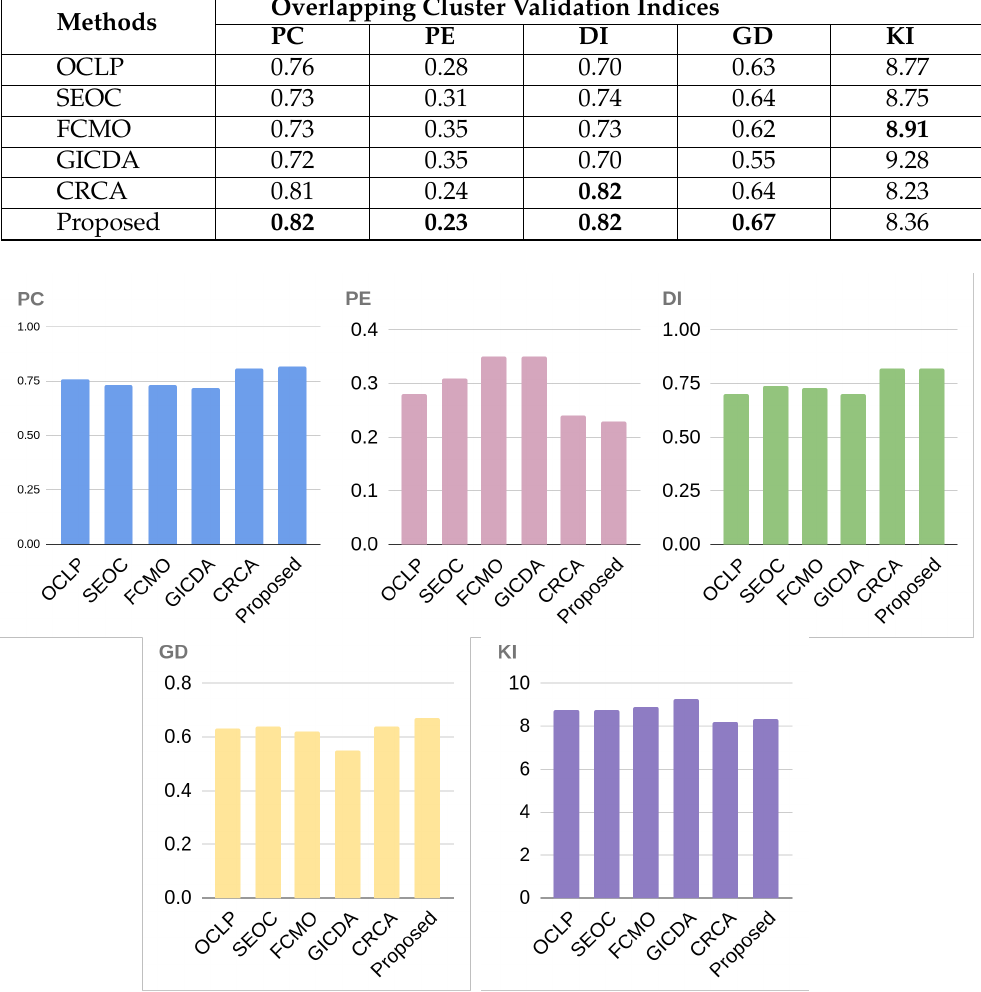
Table 5. Average overlapping indices of different algorithms.